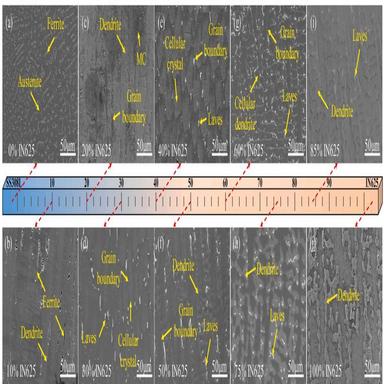
Microstructure of the FGM from 100 wt% of SS308L (a) to 100 wt% IN625 (j), with weight fractions of IN625 marked.